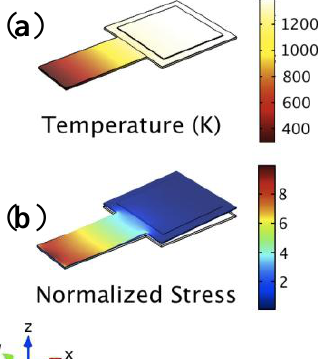
Figure 2. Simulation results obtain on different physical domain: ( a ) temperature distribution among the structure and ( b ) normalized displacement of the resonator at its first resonance mode. The bending stress is confined at the base of the cantilever where temperature changes are minimal, so that the influence of temperature on the elastic constant is